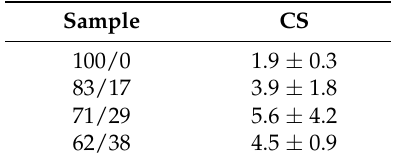
Table 5. Compression set of the analyzed blends.